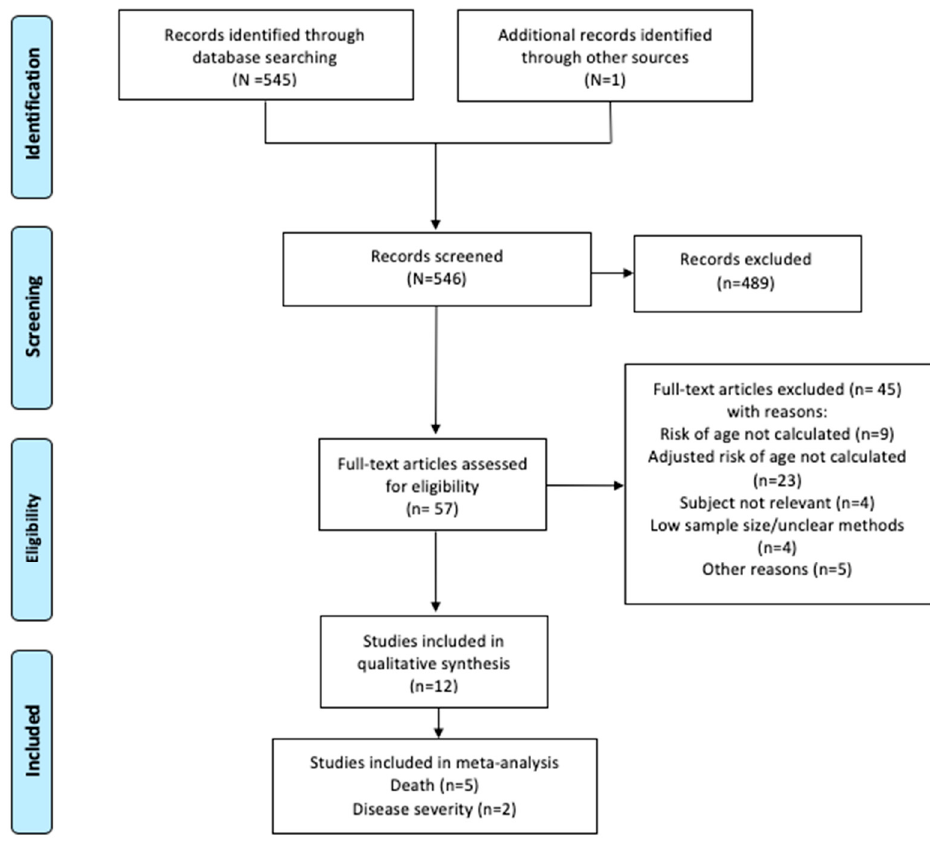
Figure 1. Study selection process.